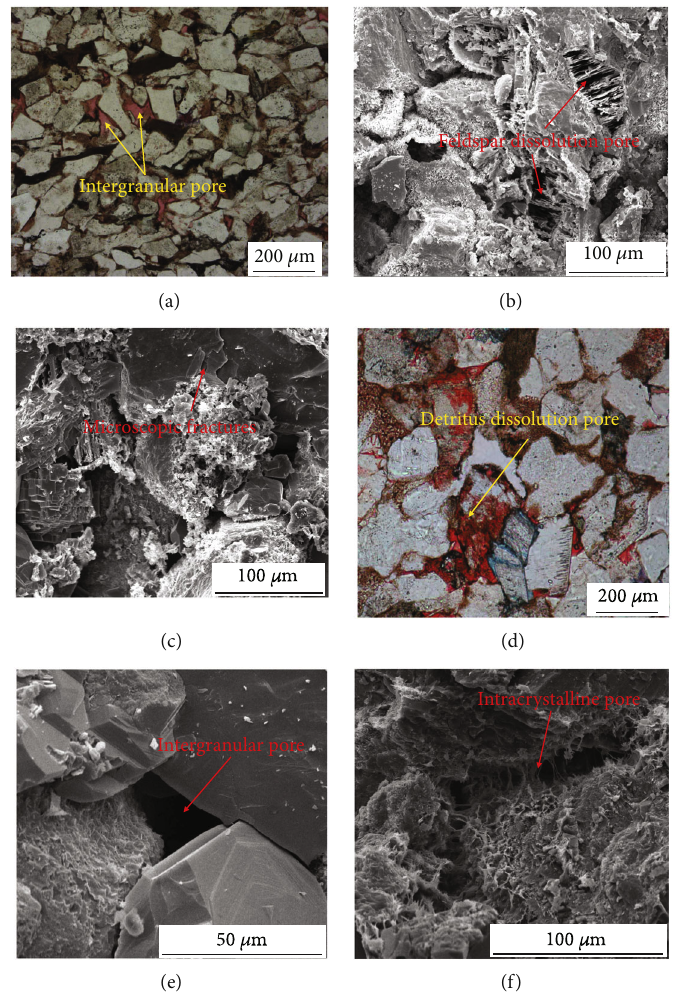
Figure 6: Photographs of CTS and SEM in the (a) Jiyuan and (b) Heshui